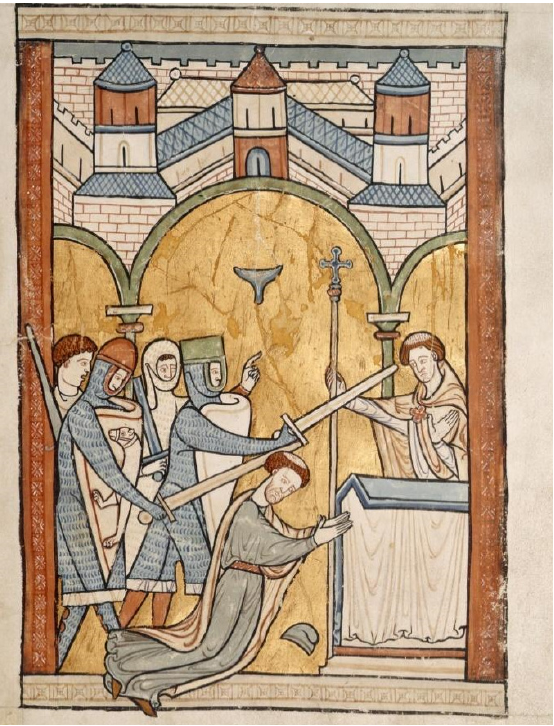
Figure 12. The martyrdom of Thomas Becket, by an English or French artist c. 1175 × 1200, British Library, London, Harley MS 5102 fo. 32r .